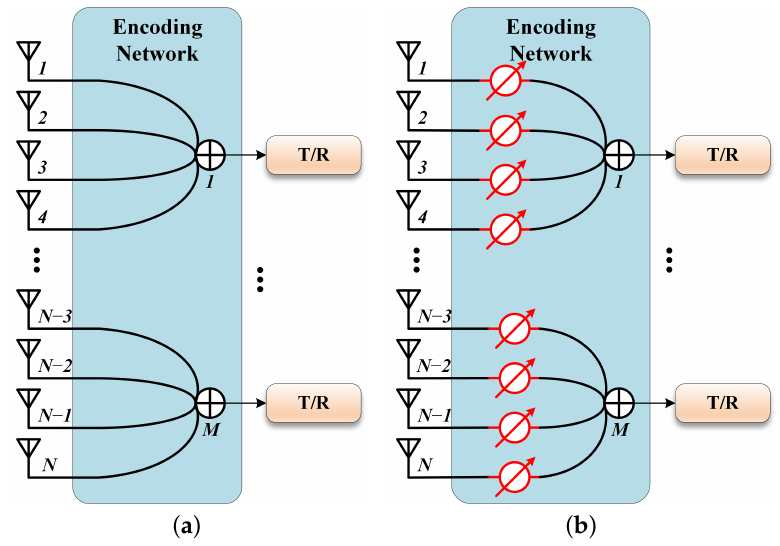
Figure 3. The encoding networks with subarray structure. ( a ) Subarray without phase shifter. ( b ) Subarray with phase